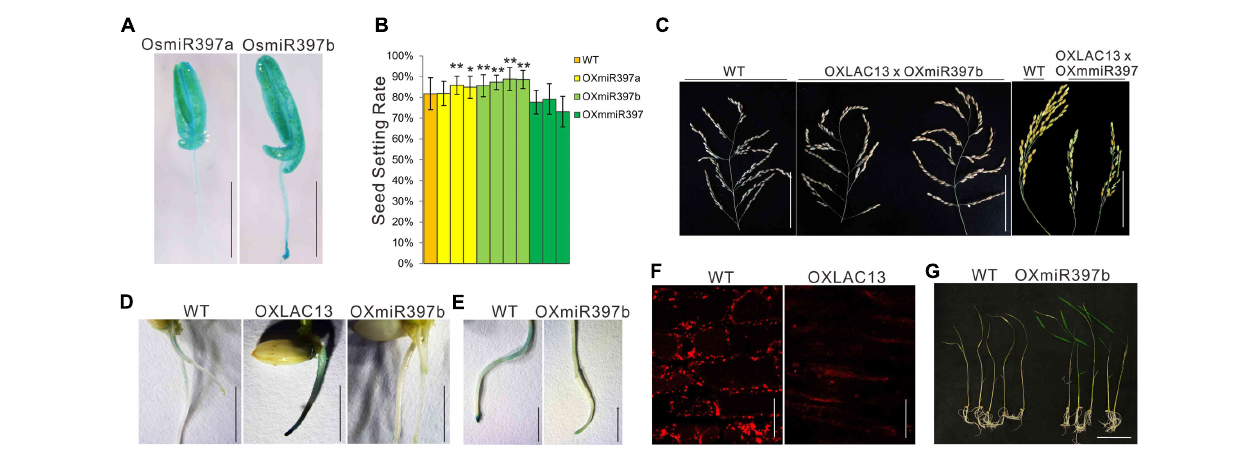
FIGURE 4 | OsLAC13 and its mediator OsmiR397 regulate hydrogen peroxide dynamics during root growth and stress response. (A) Expression patterns of OsmiR397a and OsmiR397b by GUS staining (Blue). Scale bars, 2 mm. (B) The seed setting rates of WT, OXmiR397a, OXmiR397b, and OxmmiR397 plants. Values are the means ± s. d. ( n = 40 plants). Significant differences were identified at the 5% ( ∗ ) and 1% ( ∗∗ ) probability levels using Student’s t -test. (C) The panicles of OXLAC13 plants crossed with OXmiR397b and OxmmiR397 plants, respectively. Scale bars, 10 cm. (D) TMB staining showed abnormal H 2 O 2 deposited at the root tips of OXLAC13 seedling, whereas slight H 2 O 2 deposited in the WT roots and no H 2 O 2 was observed in the OXmiR397 roots. Scale bars, 5 mm. (E) TMB staining of the WT and the OXmiR397 roots after 24 h MV treatment. Scale bars, 2 mm. (F) The mitochondria in WT and OXLAC13 root tips were stained by Mito Tracker red. No evident mitochondrion was observed in the OXLAC13 root tip. Scale bars, 20 µ m. (G) The WT and OXmiR397b seedlings after 1 days MV treatment and 3 days recovering. Scale bars, 5